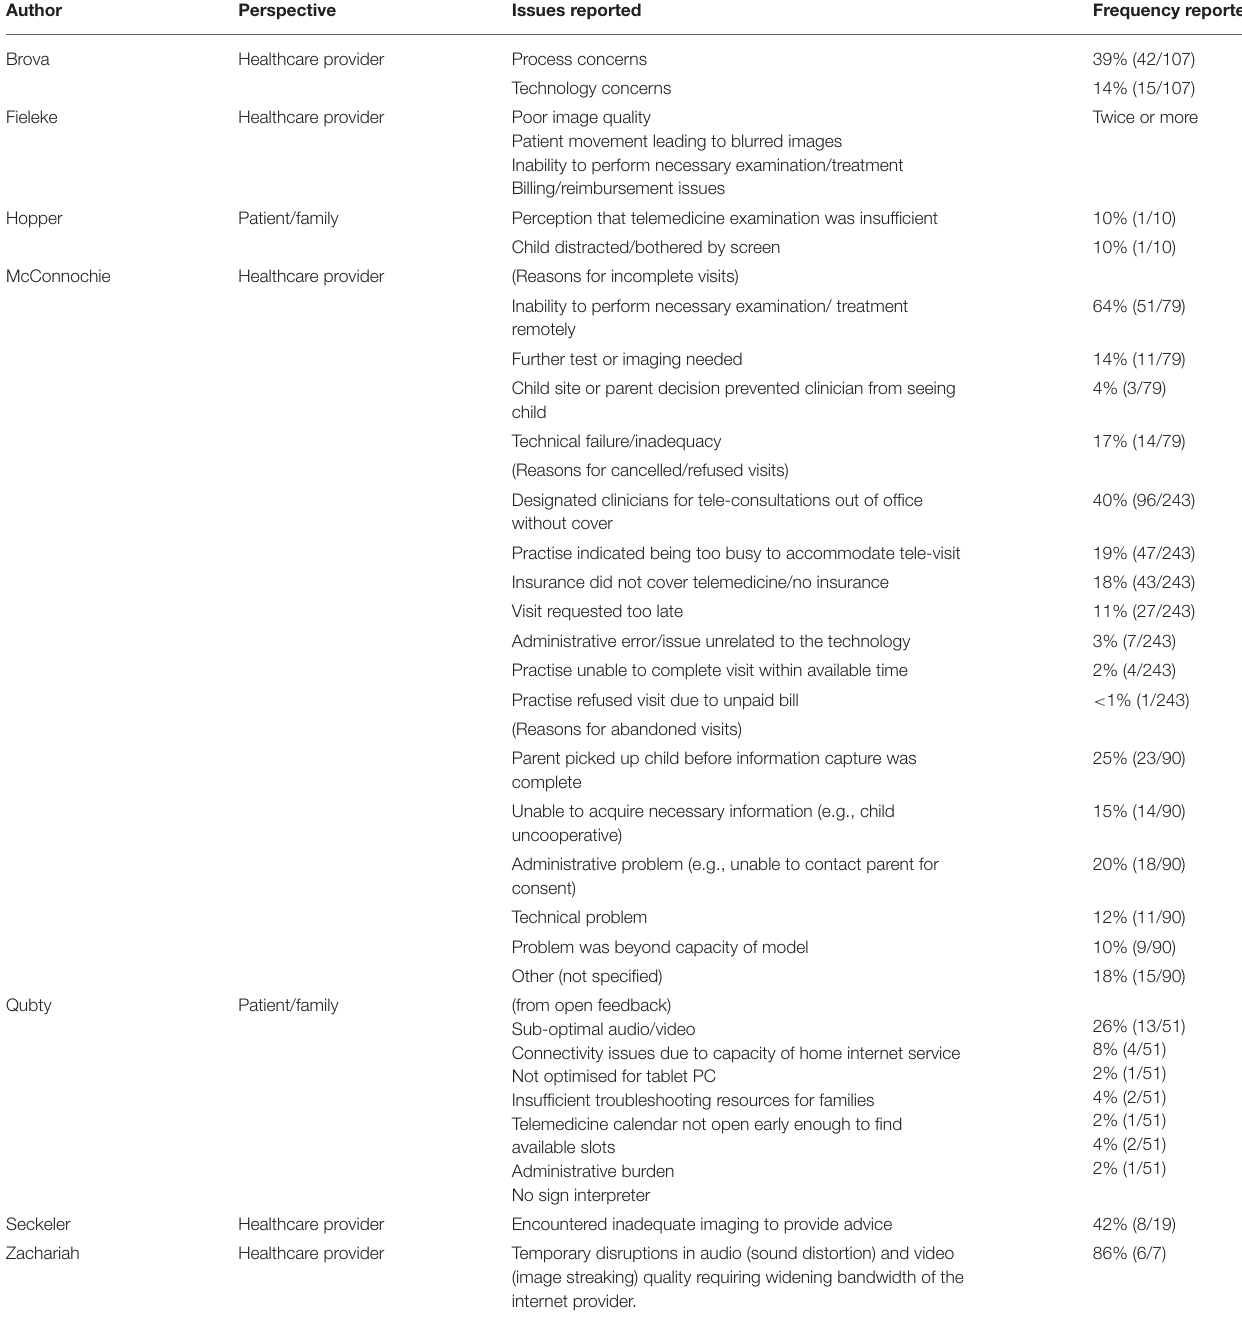
TABLE 3 | Reported challenges encountered during use of